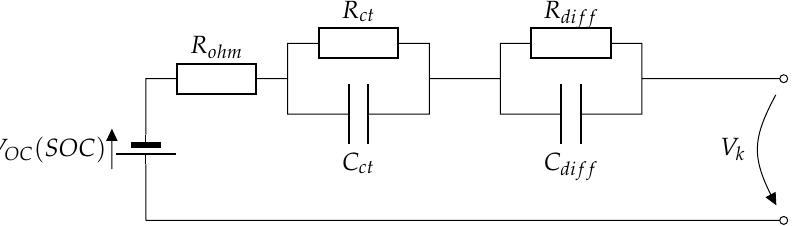
Figure 4. Used ECM containing two RC elements and a SOC-dependant OCV. All parameters in the schema are estimated using least-squares method. V k and the current serve as reference for the